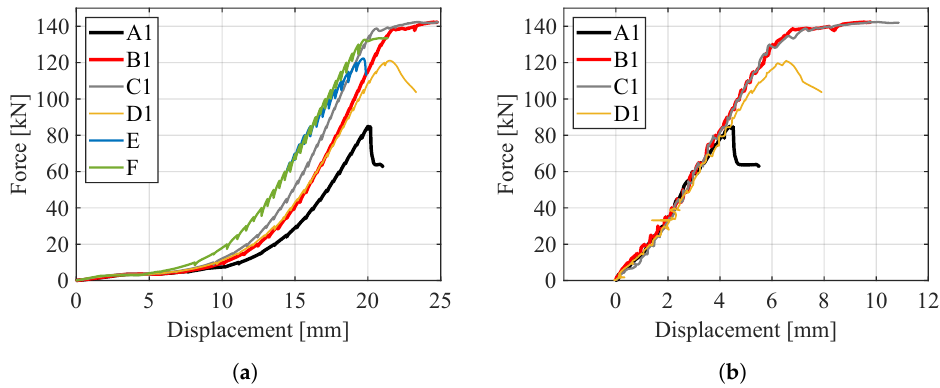
Figure 15. ( a ) Force–mid-displacement measured using the MTS machine for the beams; and ( b ) force measured using the MTS machine and mid-displacement measured using DIC for the